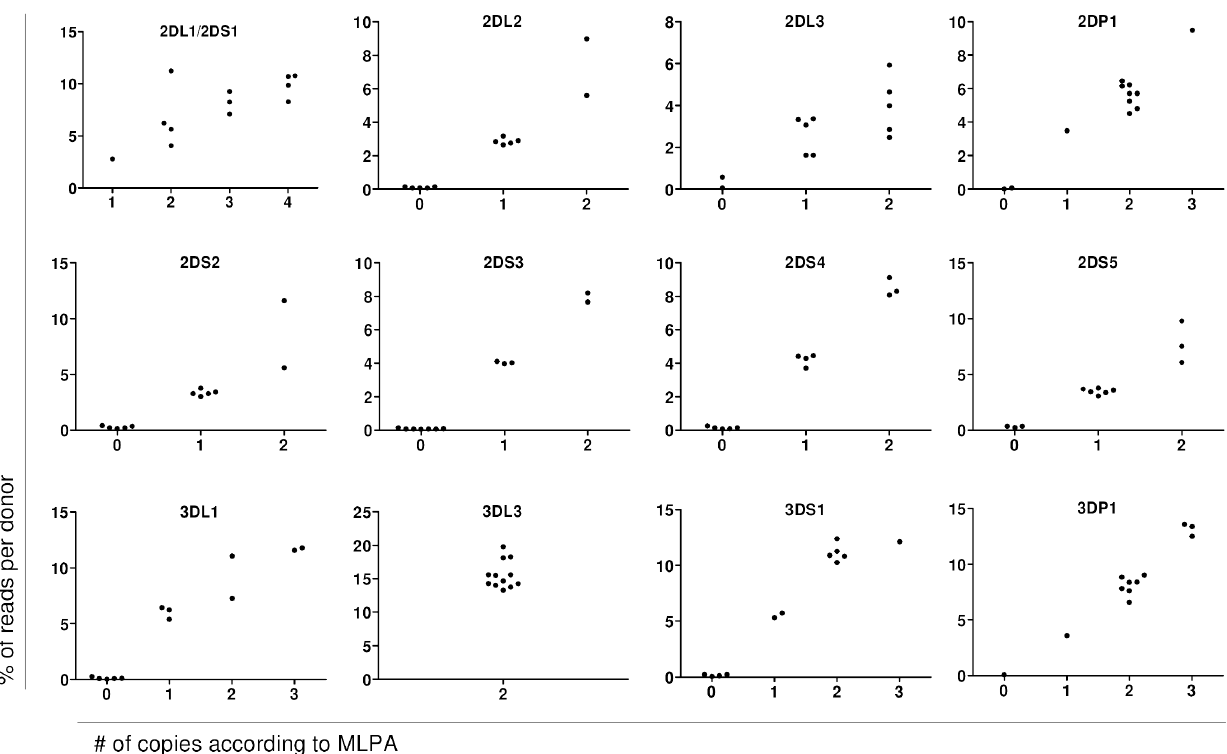
Figure 3. Validation of the KIR MLPA method with an independent short tandem repeat (STR) assay. A primer set was used to amplify a stretch of repeats that occurs in intron 4 of most KIR genes. Next-generation sequencing (NGS) was used to sequence the amplification products based on both specific sequence and number of repeats. The graphs show the percentage of reads in NGS, aligned against the reference sequence of that KIR, in donors with a certain number of copies of that gene as determined by MLPA. The number of reads of framework gene KIR3DL2 was used as a reference to adjust for the total number of genes per donor. KIR2DL1 and KIR2DS1 have the same number of STR and no SNPs to distinguish one from the other and have therefore been combined. Several SNPs within the repeat region of KIR2DL3 and KIR3DL3 confirm the copy numbers as found with the MLPA method.